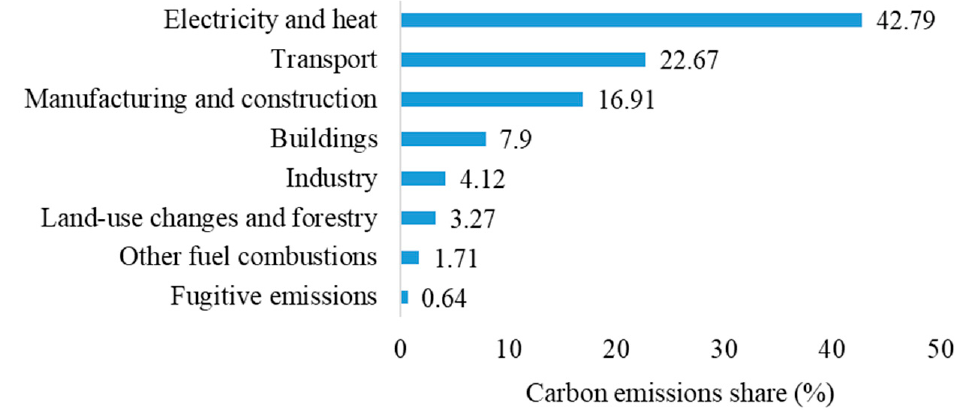
Figure 1. Distribution of CO2 emissions across different sectors [4].